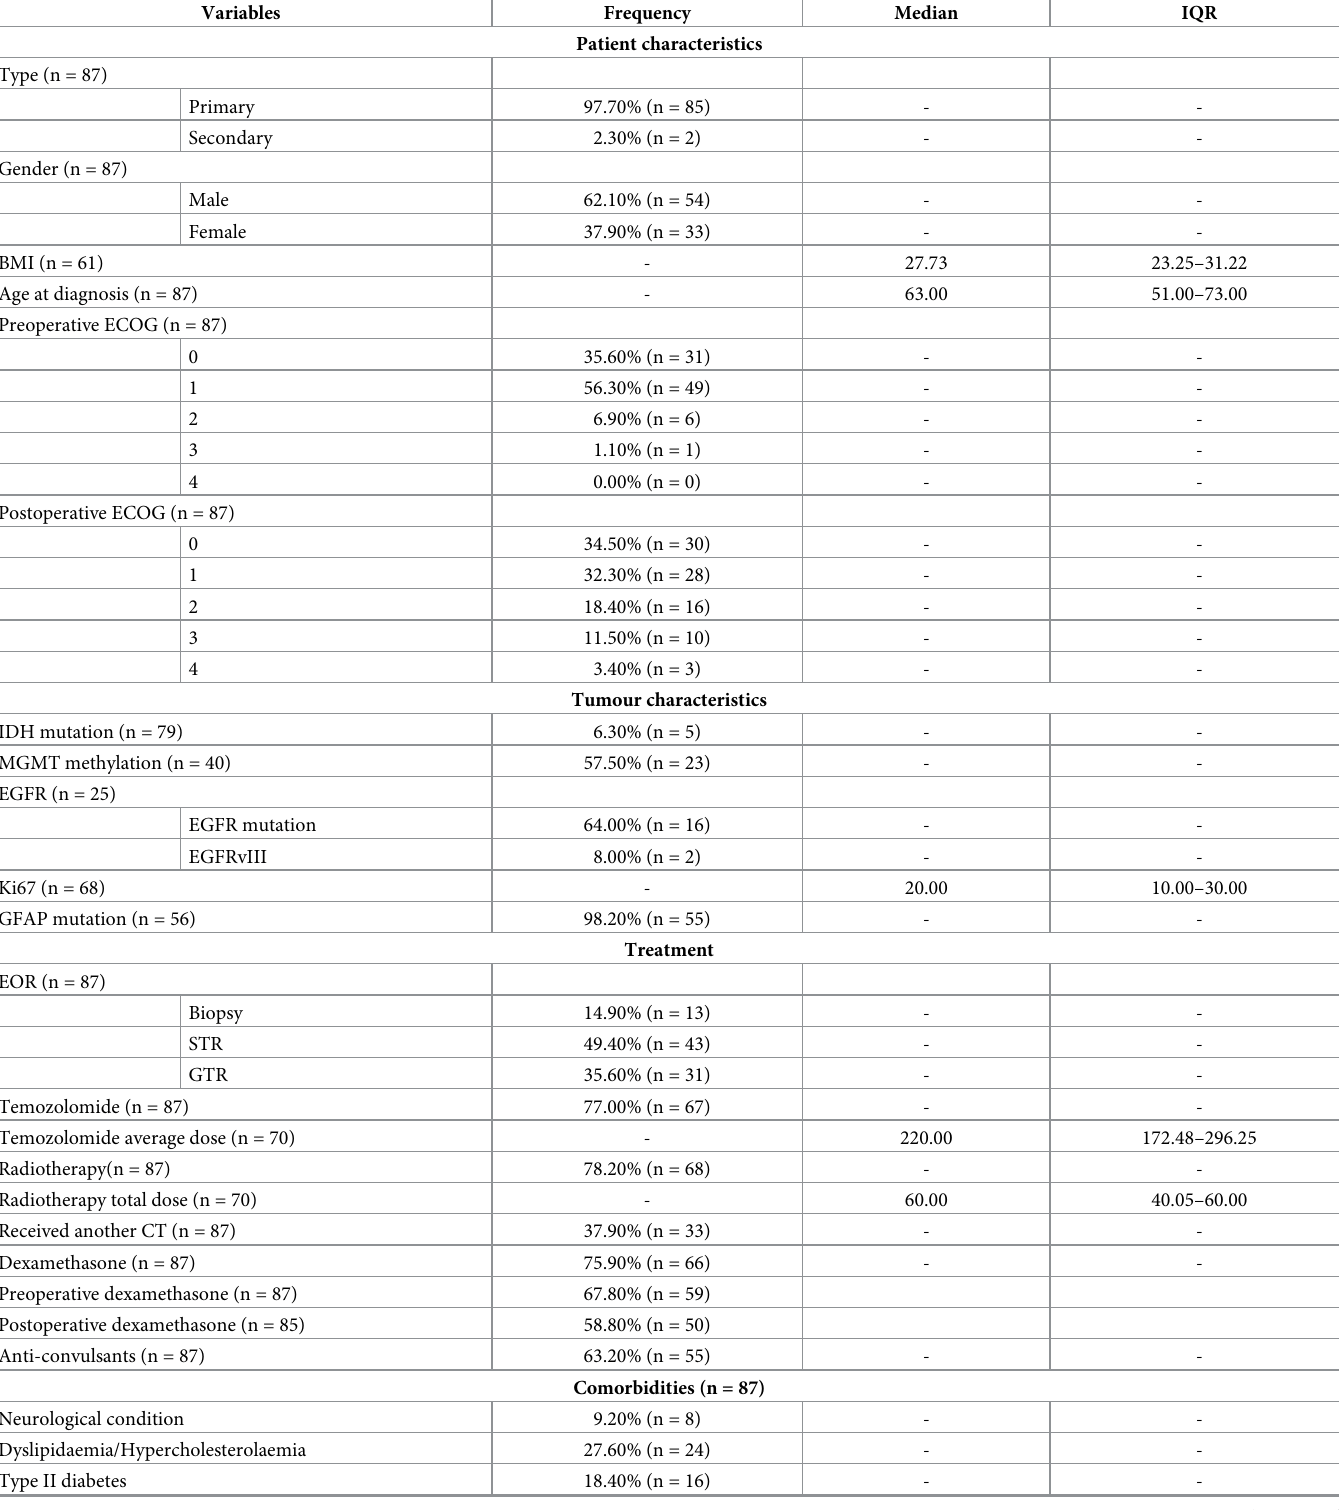
Table 1. Patient variables stratified by patient and tumour characteristics, treatment and